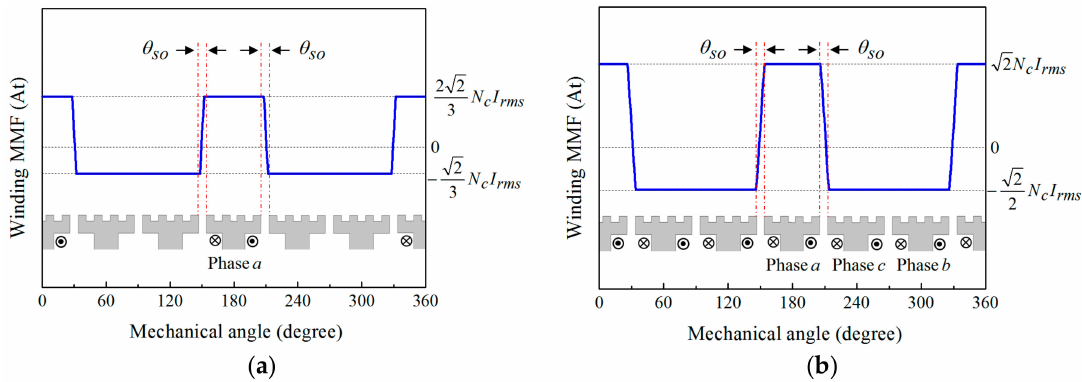
Figure 2. The magneto-motive force (MMF) distributions when the time is zero. ( a ) Due to the a -phase winding; ( b ) due to the three-phase